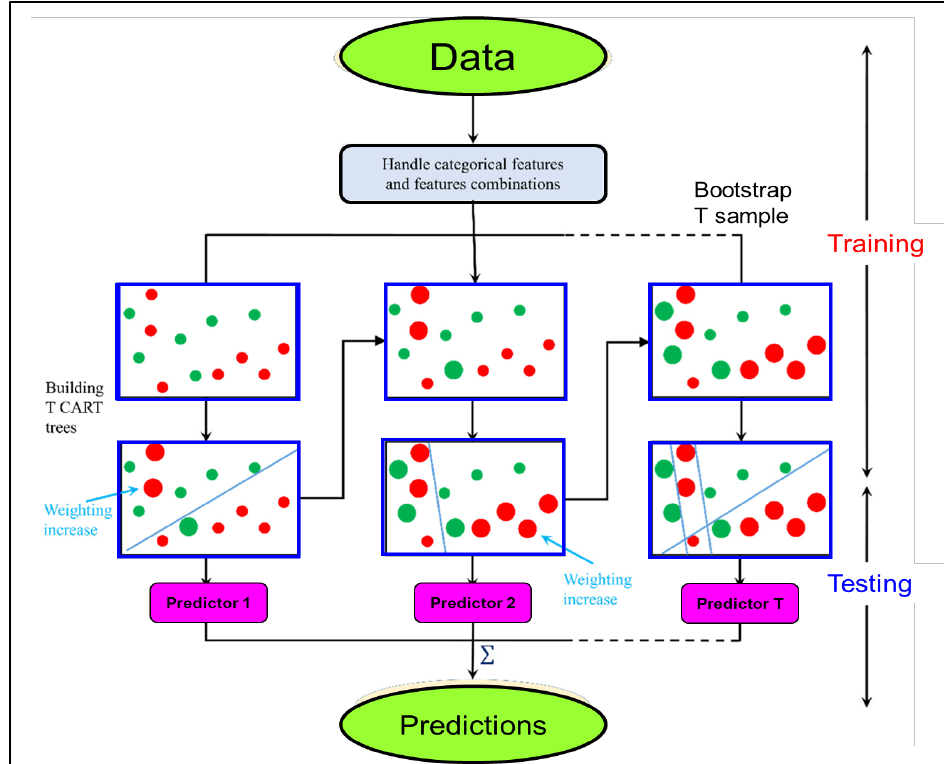
Figure 7. CatBoost schematics [107].